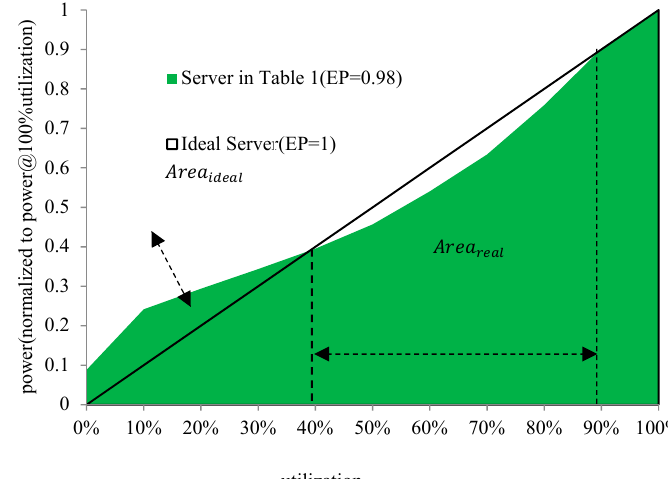
Figure 4. Comparison of EP curve (or power curve) of the server in Table 1 and an ideally energy proportional server (power normalized to power at 100% utilization).